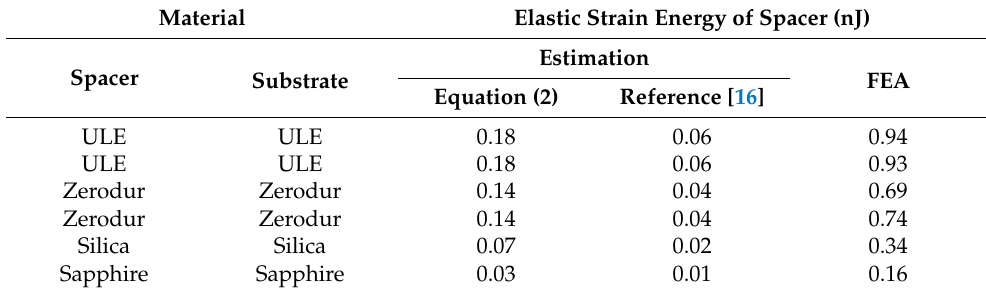
Table 3. The elastic strain energy of the spacer calculated by FEA and two